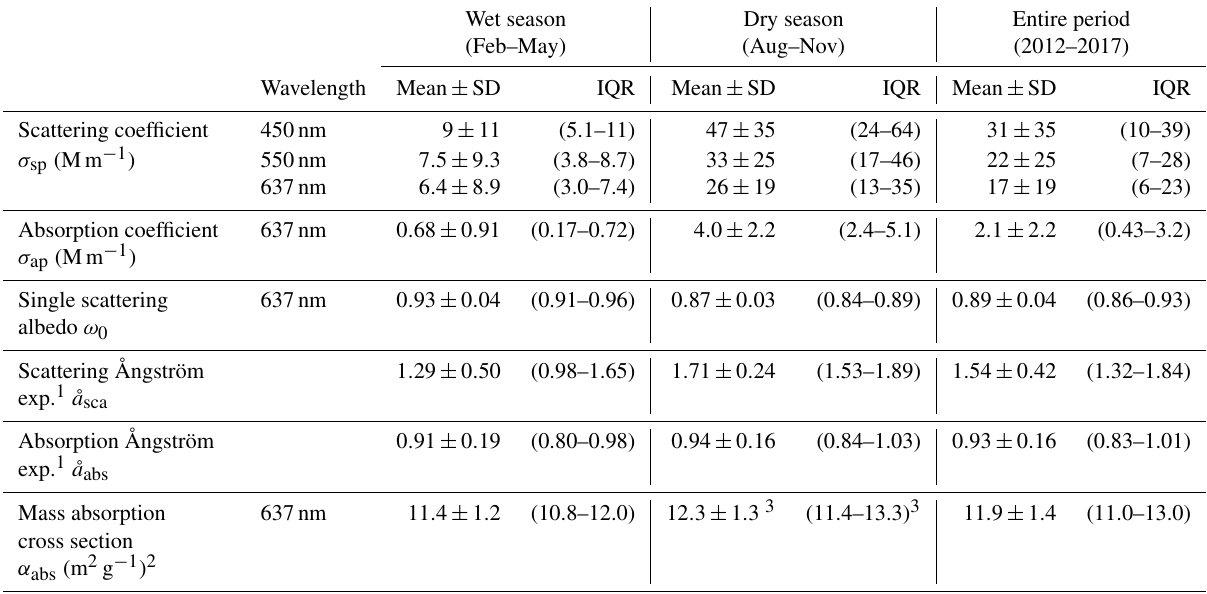
Table 1. Descriptive statistics (mean ± standard deviation and interquartile range, IQR) of daily averaged aerosol optical properties over the Amazon rainforest during the different seasons and the entire measurement